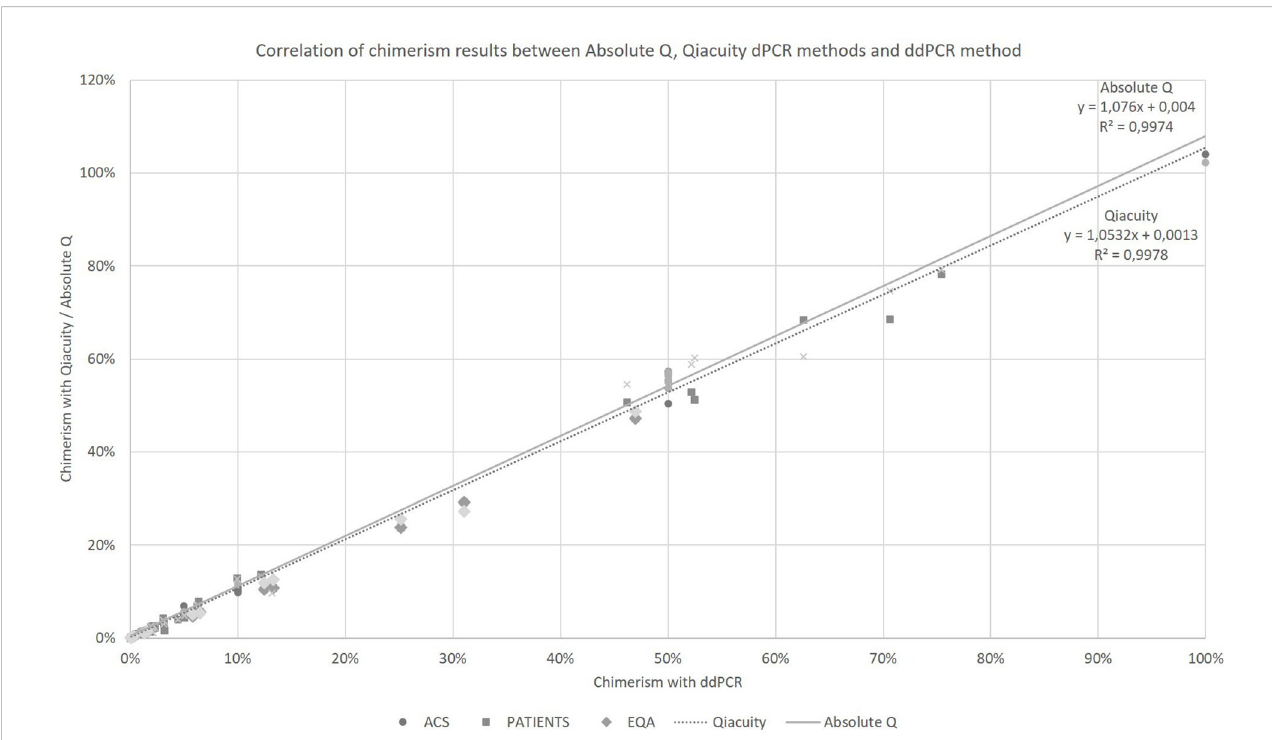
FIGURE 1 Correlation of chimerism results between Absolute Q, Qiacuity dPCR and ddPCR method (reference method). ACS. Arti fi cial Chimeric Samples; EQA. External Quality